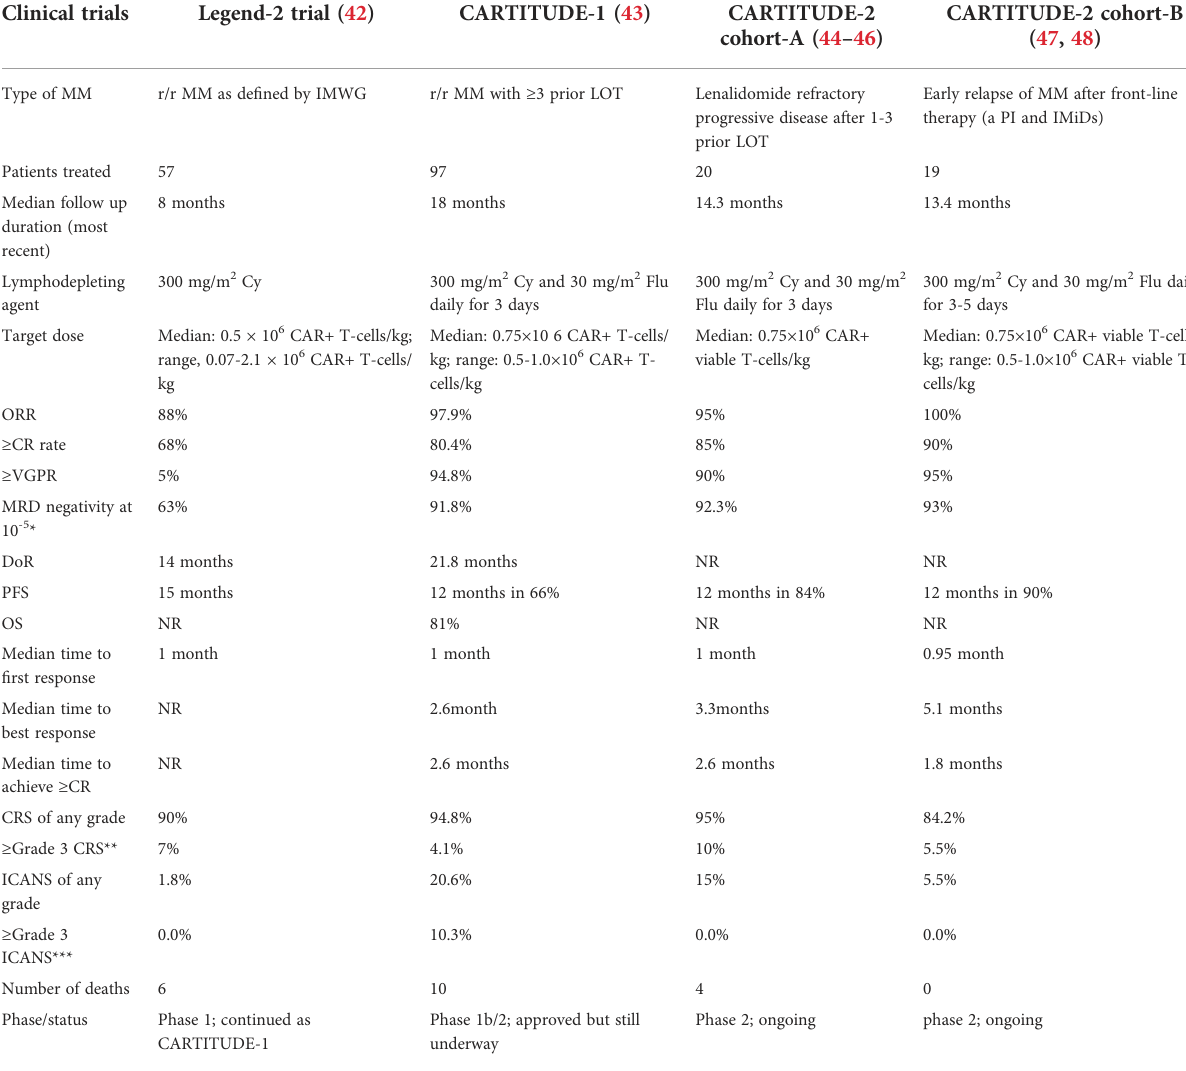
TABLE 1 A summary table on the ef fi cacy and adverse effects of cilta-cel in different clinical trials from their respective updated